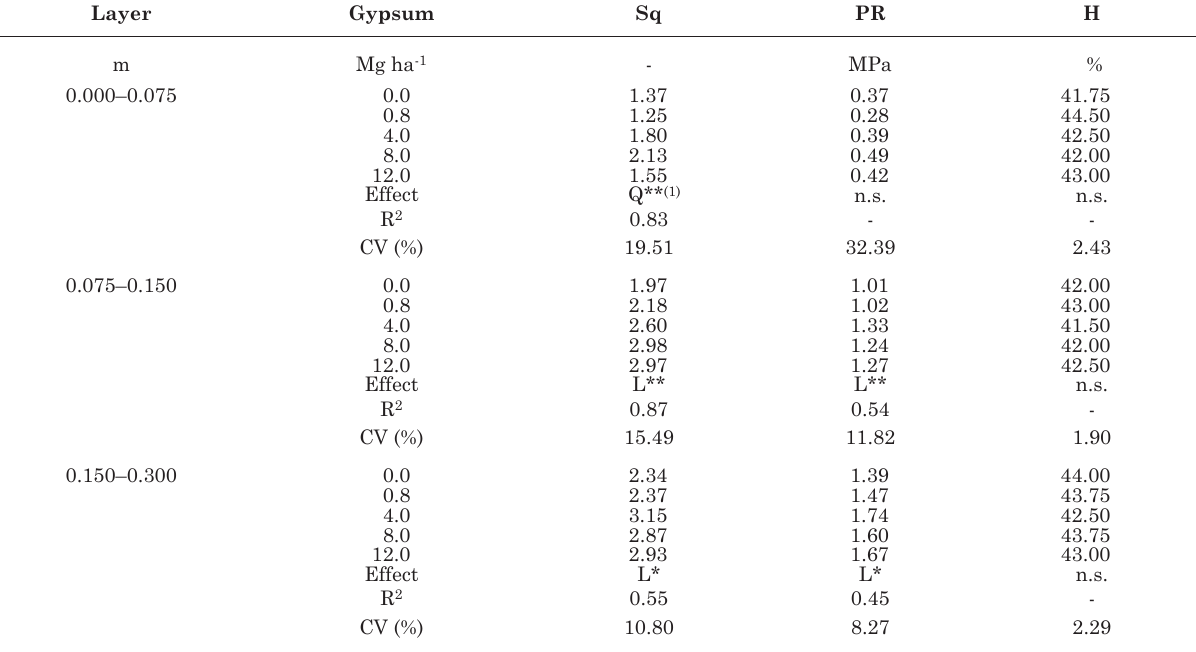
table 1. Soil structural quality (Sq) scores, penetration resistance (pr) and gravimetric moisture in different layers of a red latosol under no-tillage, 50 months after application of gypsum rates to the soil surface (guarapuava, 2009) layer